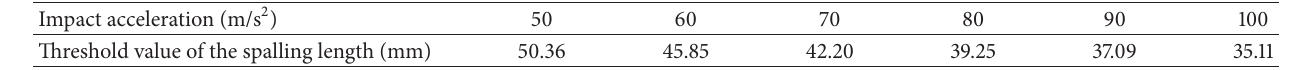
Table 1: Threshold value of the spalling length with different impact acceleration.